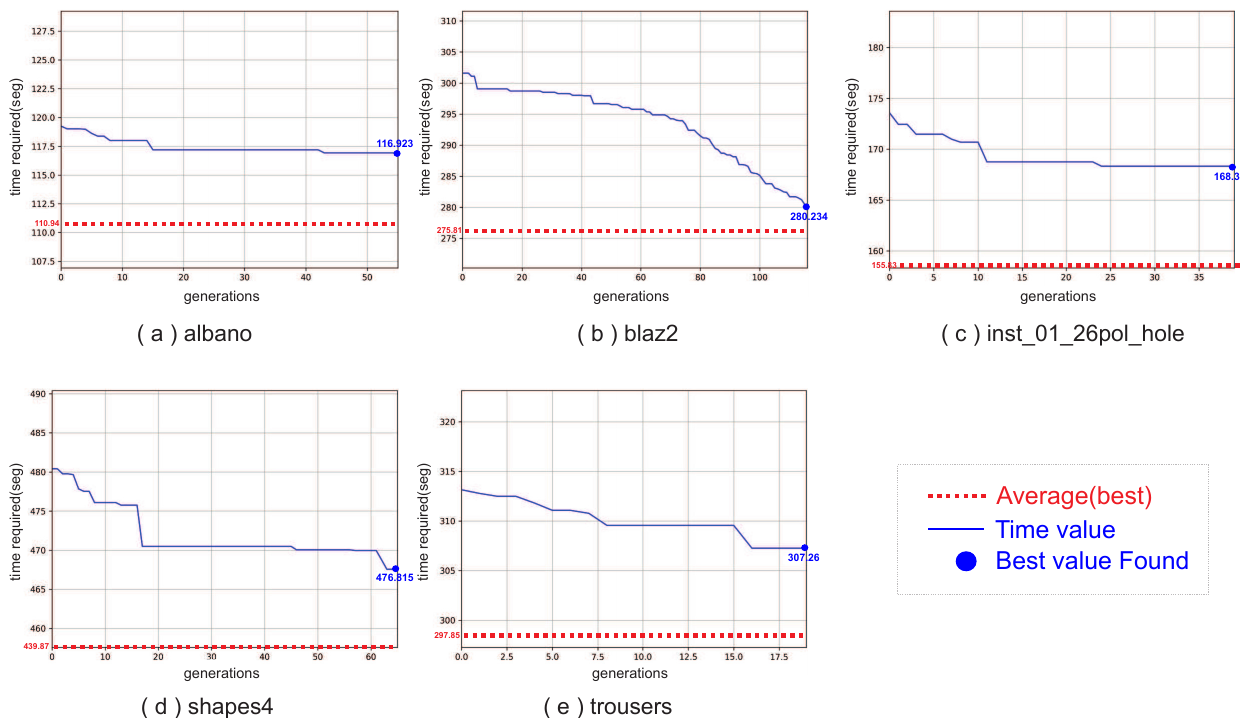
Figure 12. Progression of the objective values through generations when addressing connected instances. BRKGA hyper- parameter: P = 10,000, P e = 0.30, and P m = 0.1.